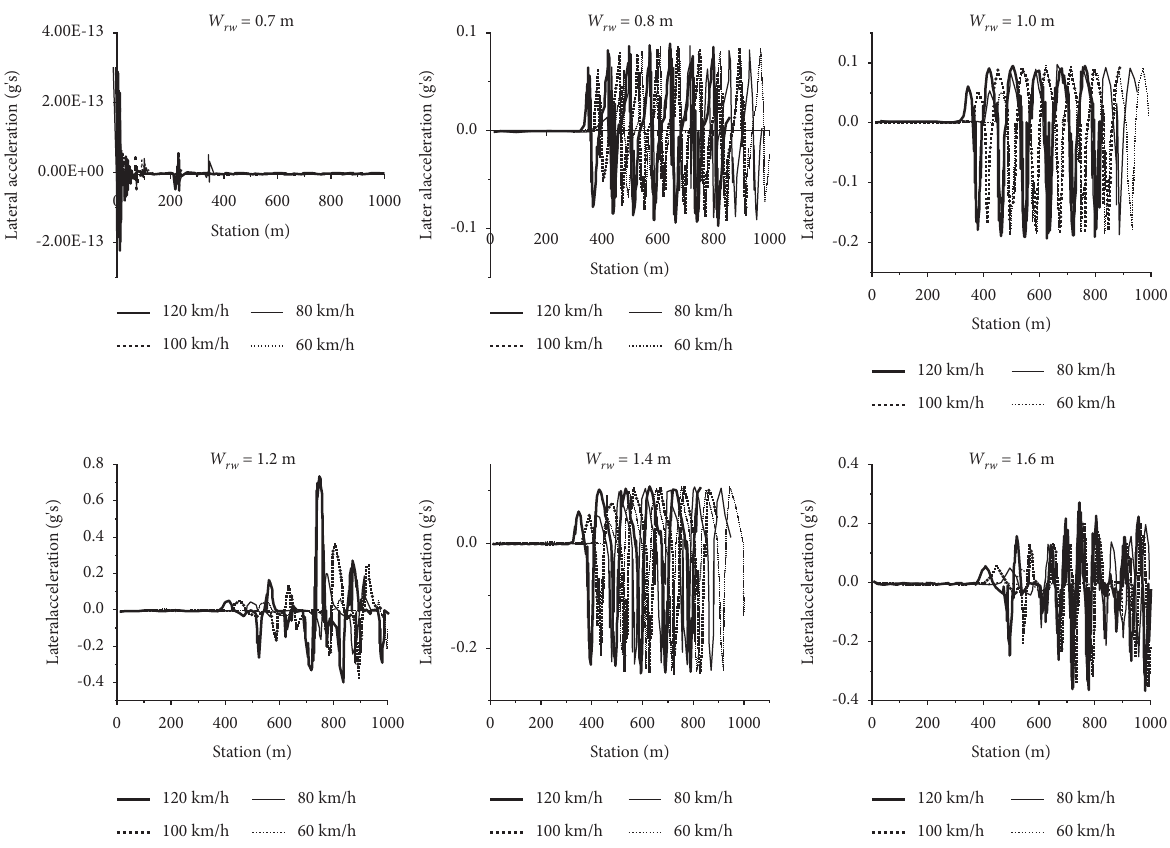
Figure 12: Lateral accelerations at different rutting widths and speeds. (a) W (e) W rw � 1.4m, and (f) W rw �